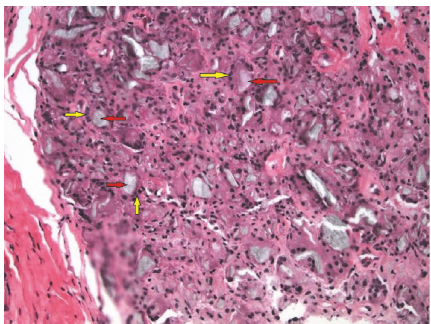
Figure 4: Microscopy of the biopsied mass from the left arm showing foreign body granulomatous reaction (high power view, 200 X). Foreign bodies (silicone materials) are shown by black arrows. These are surrounded by multi-nucleated giant cells (white